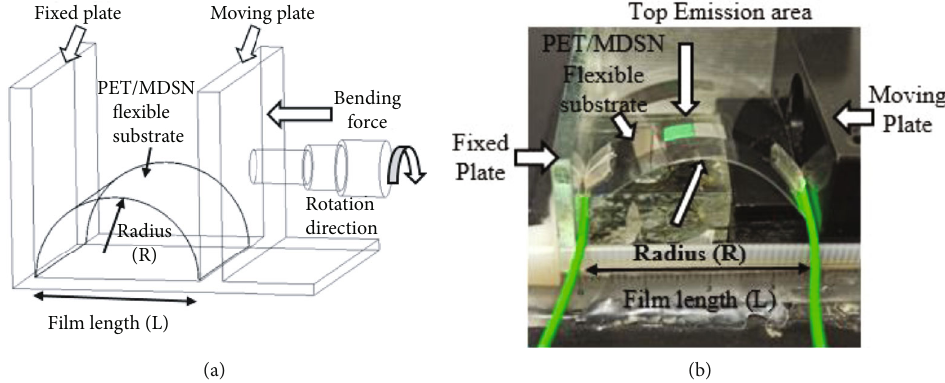
Figure 2: (a) Flexibility test equipment and (b) PET/MDSN substrate fl exibility